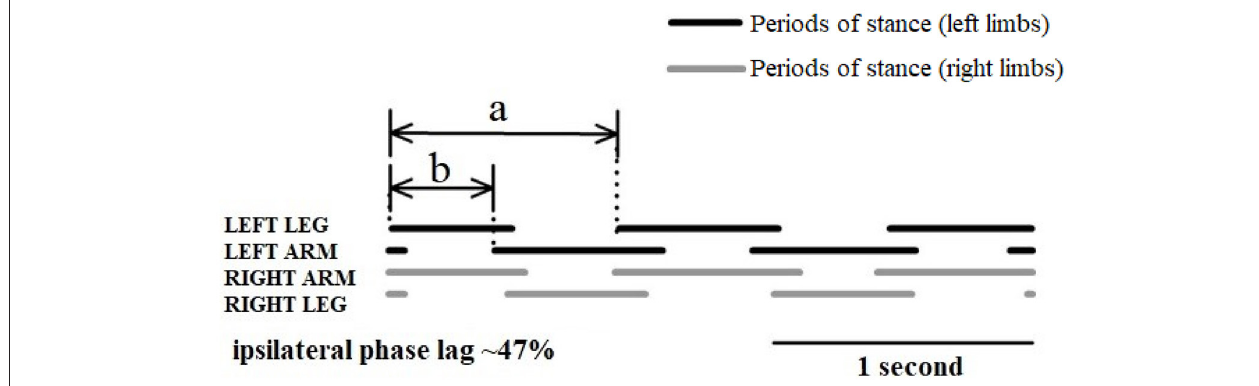
FIGURE 7 | Schematic diagram of interlimb coordination during crawling illustrated with the periods of stance (solid lines) and swing (spaces) (24).